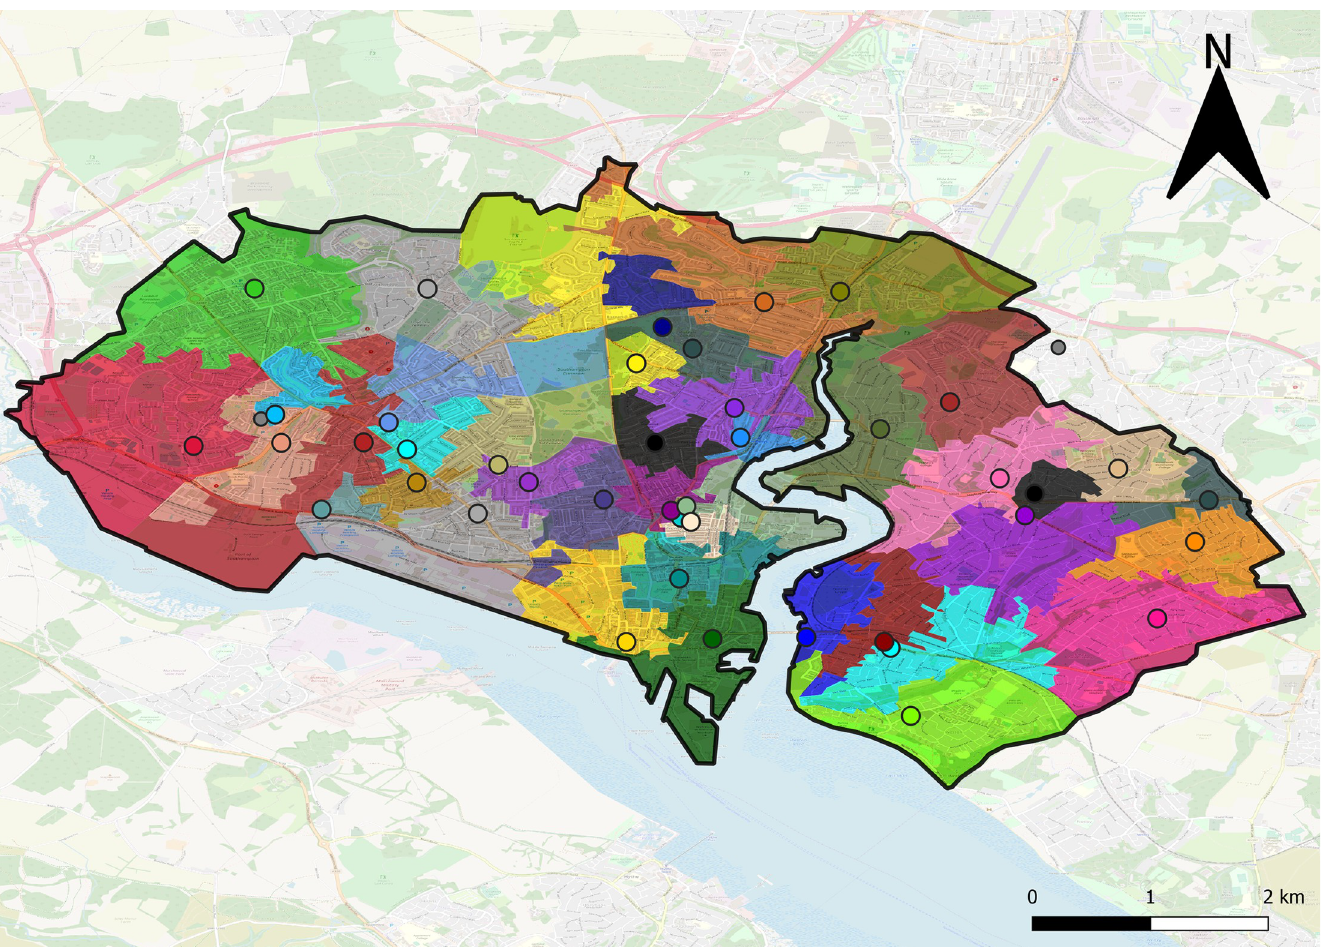
Fig 3. Assignment of patients to GP surgeries for the city of Southampton. Considering a high testing demand estimation and T = 1 m. Each circle represents a GP surgery, same colour indicates assignments. Smaller grey circles indicate that no machine was allocated to that GP surgery. This assignment requires 42 machines in total. Map data copyrighted OpenStreetMap contributors and available from